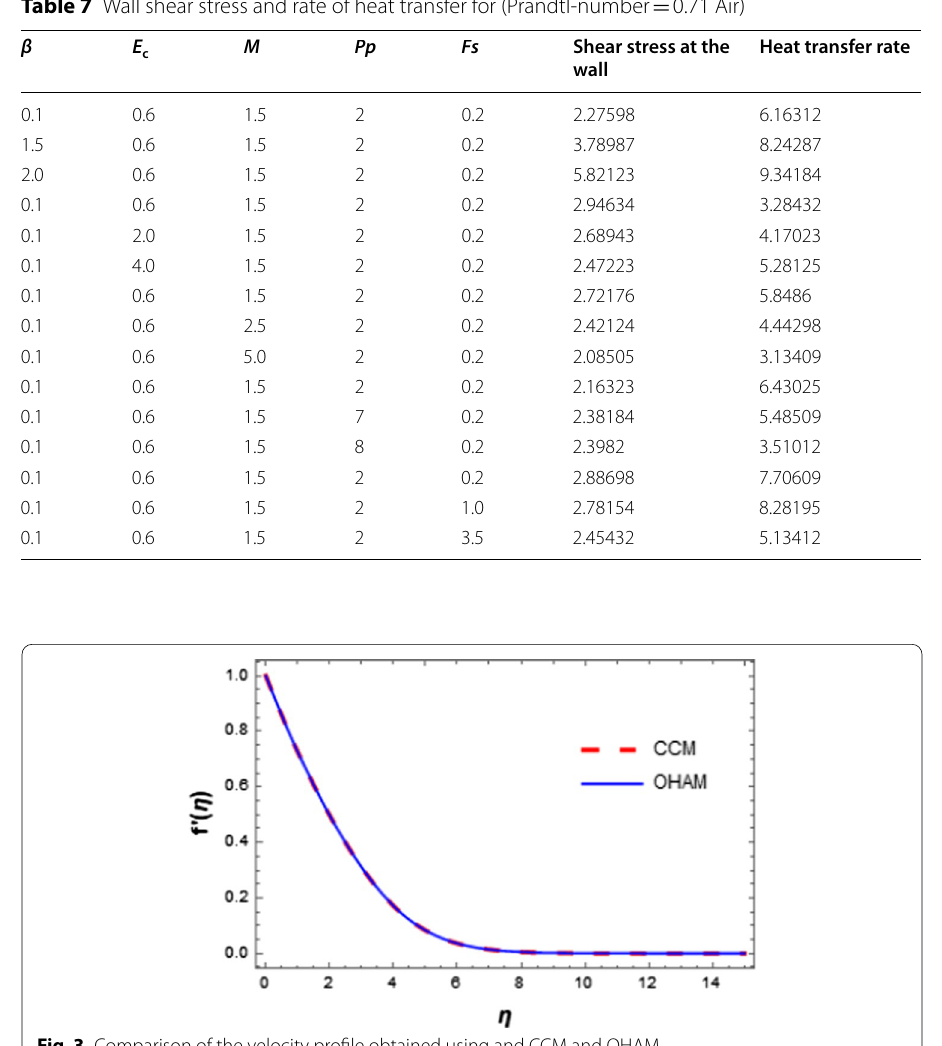
Table 7 Wall shear stress and rate of heat transfer for (Prandtl-number